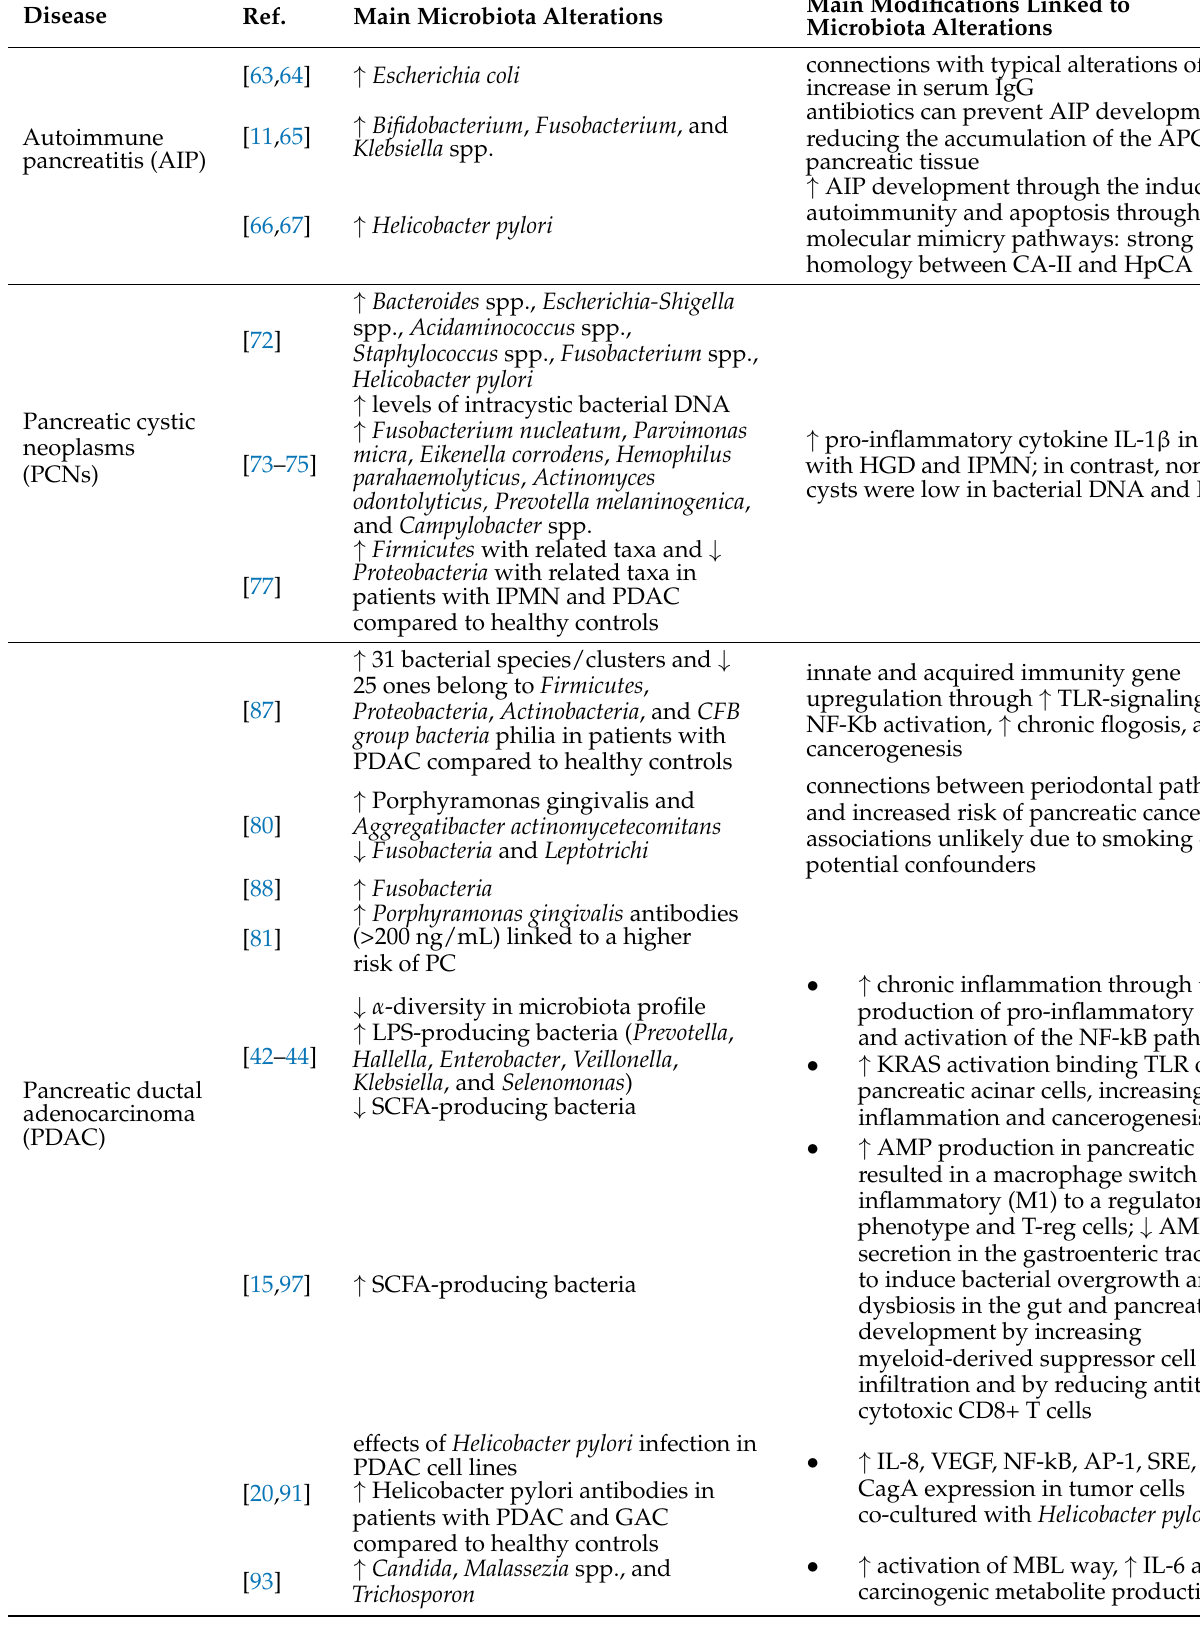
Table 1. Main microbiota alterations and linked modifications observed in pancreatic diseases.